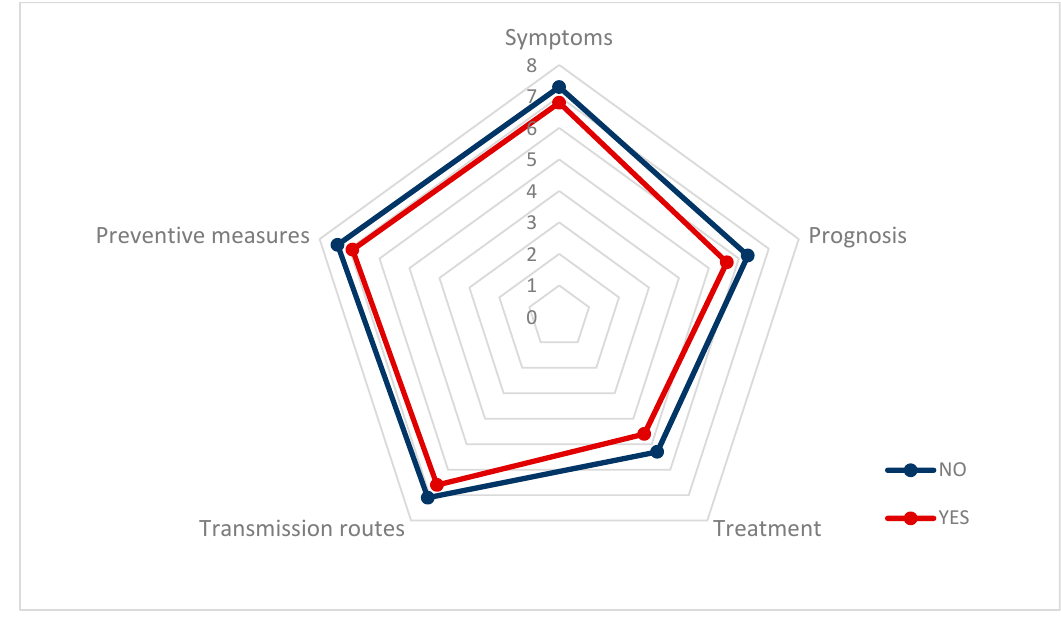
Figure 1. Information that non ‐ health workers believe about COVID ‐ 19, distinguishing between the presence or absence of psychological distress.